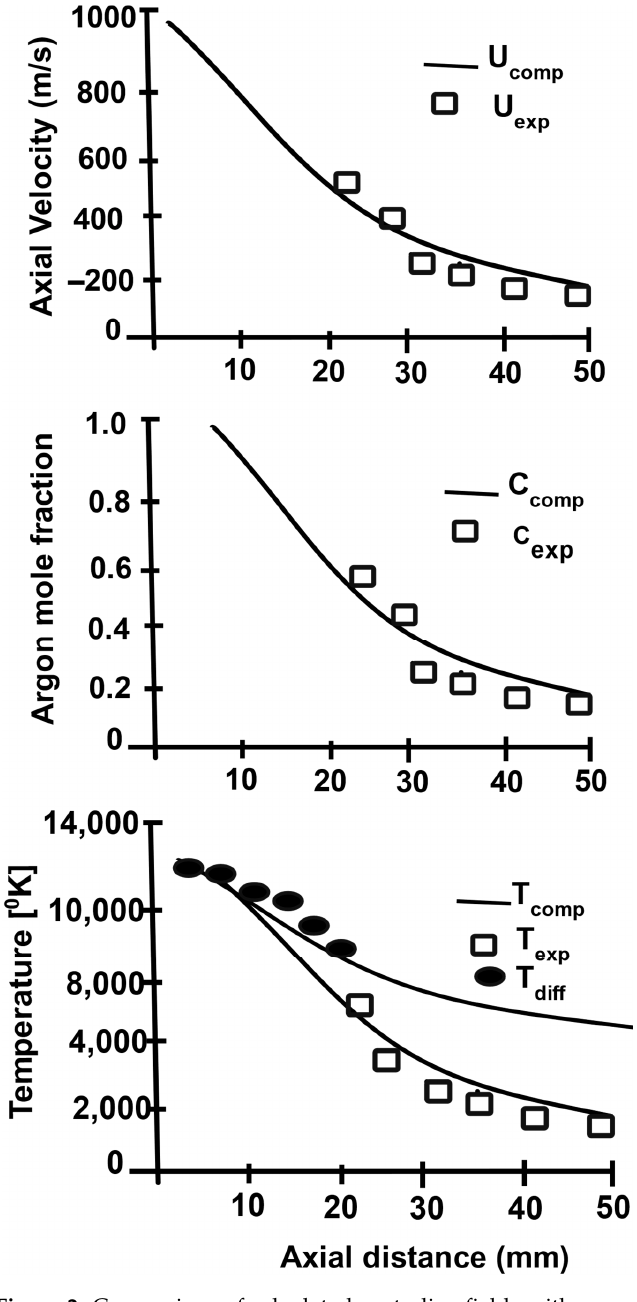
Figure 2. Comparison of calculated centerline fields with experimental data. Reprinted from [18] with permission from Springer 1991.